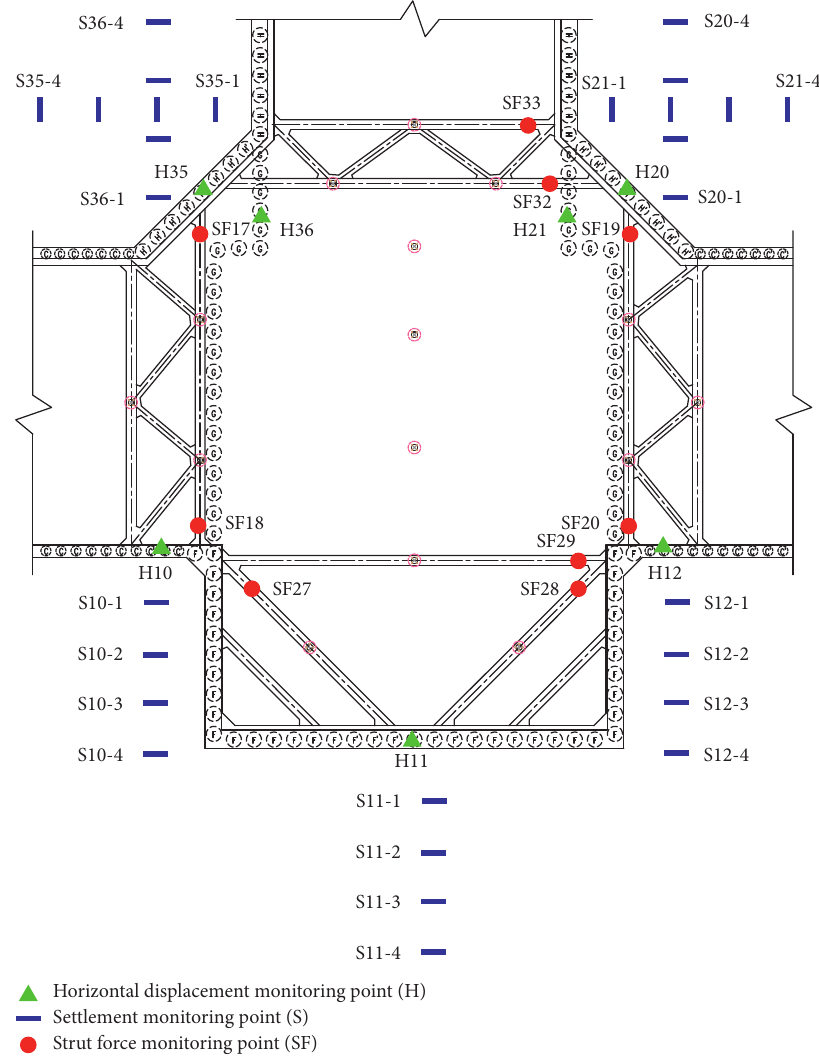
Figure 5: Layout of monitoring points. Table 4: The accuracy of each